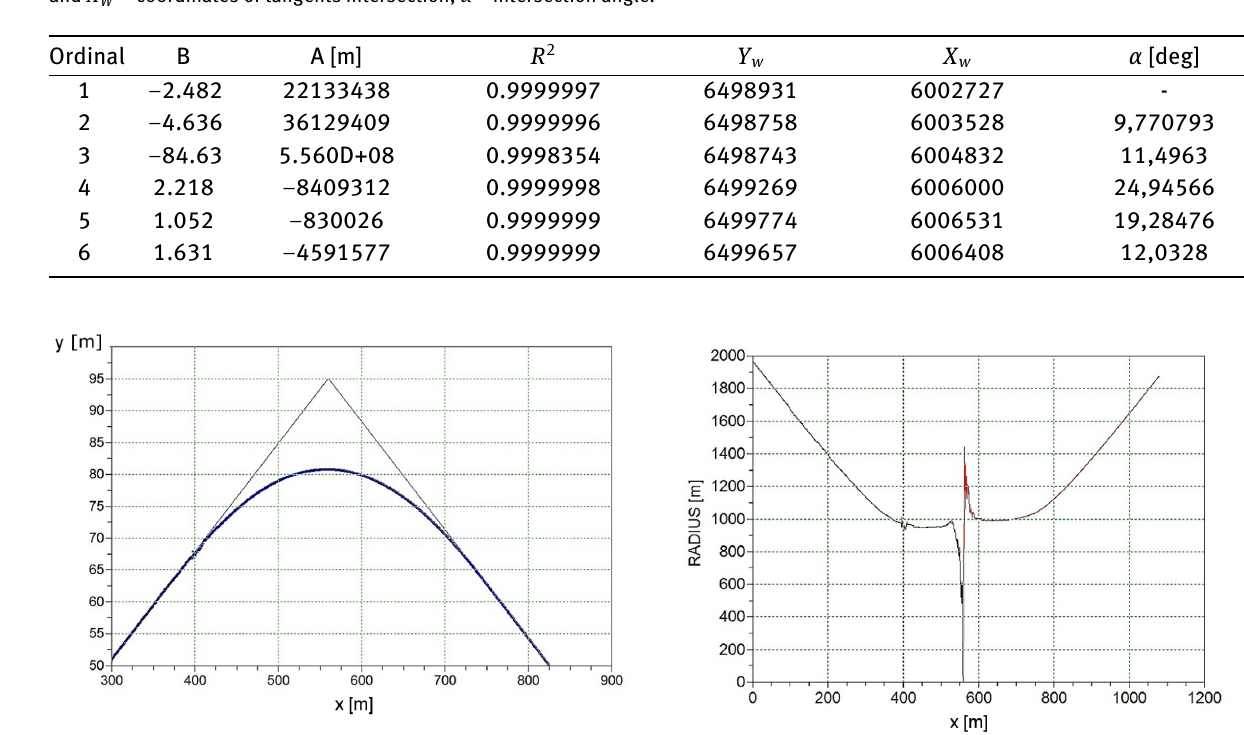
Table 1: Exemplary input data for polygon analysis. B – tangent inclination, A – intersection with vertical axis, R 2 – fitness coeflcient, Y W and X W – coordinates of tangents intersection, α – intersection angle.